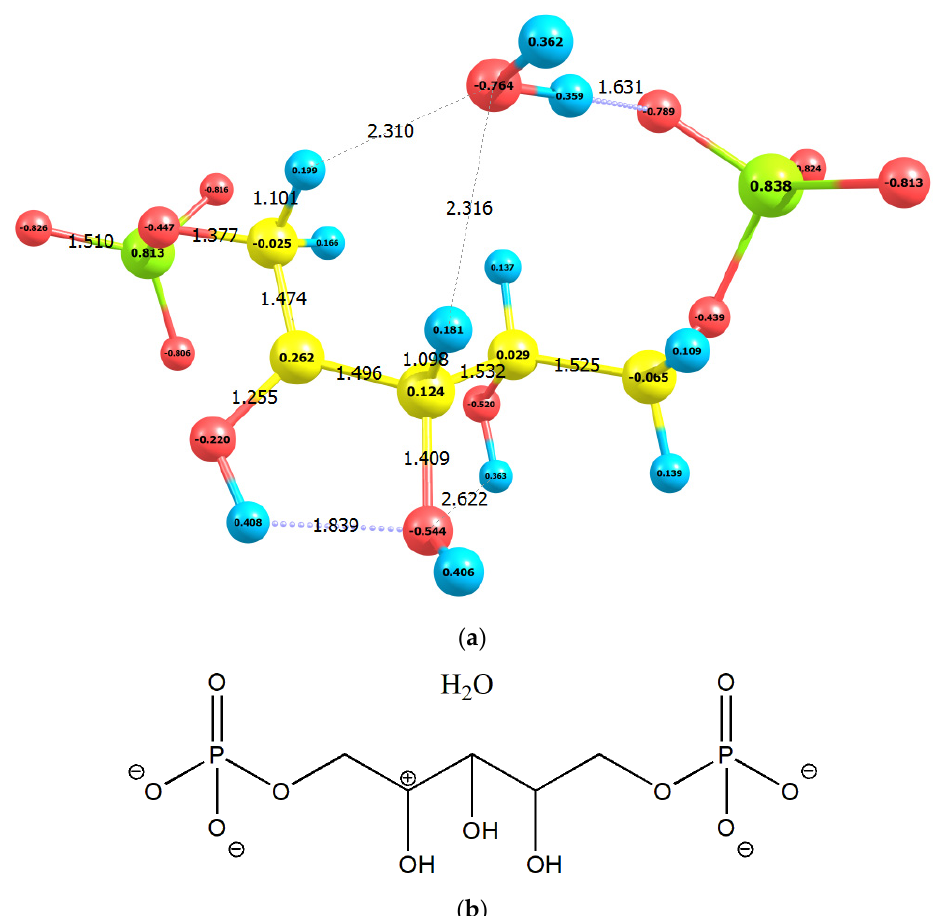
Figure A2. ( a ) The calculated geometric and electronic structure of protonated ribulose-1,5-bisphosphate with single water molecule (RuBP1 + · H 2 O); Q = − 3, M = 1, E 0 = − 48,530.12 eV, G 0 = − 48,525.85 eV. Hessian has negative frequencies: − 26.56 (cm − 1 ). ( b ) The scheme of 2,3,4-trihydroxypentan-2-ylium-1,5-diyl diphosphate.